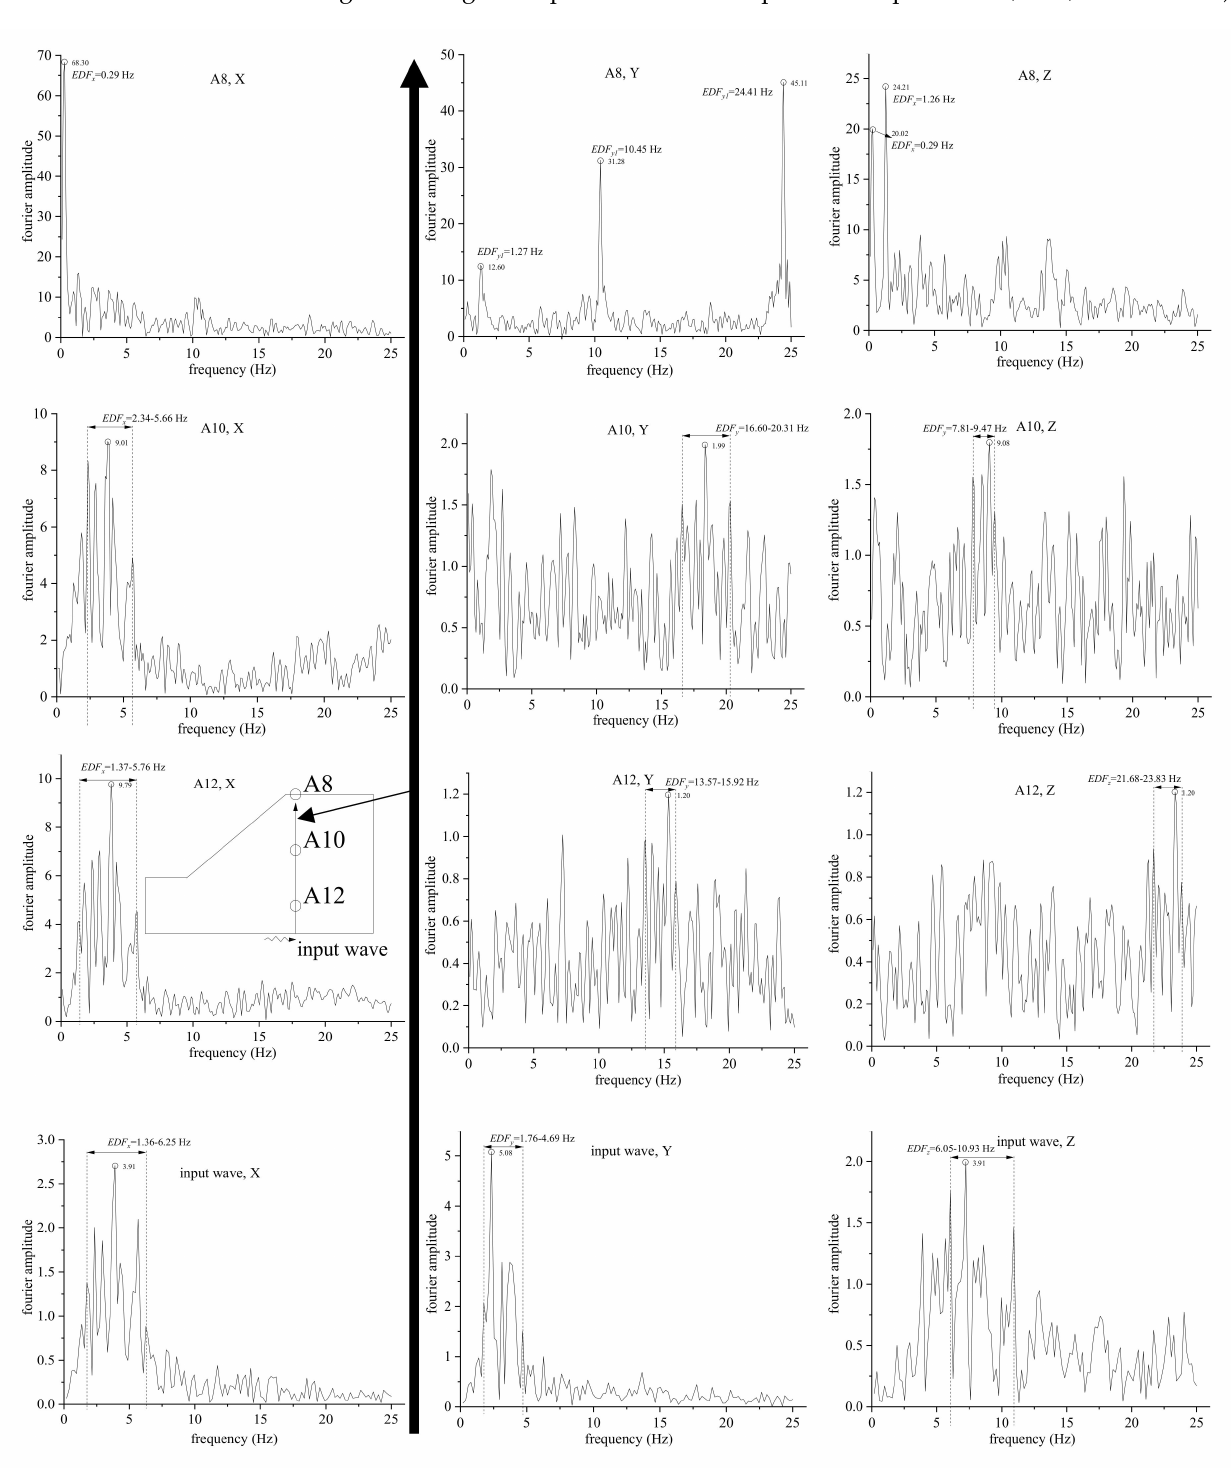
(The data in Figure 10 are arranged to emphasize how the form of the seismic vibration changes as it migrates upwards from the input level to points A12, A10, and then A8.)